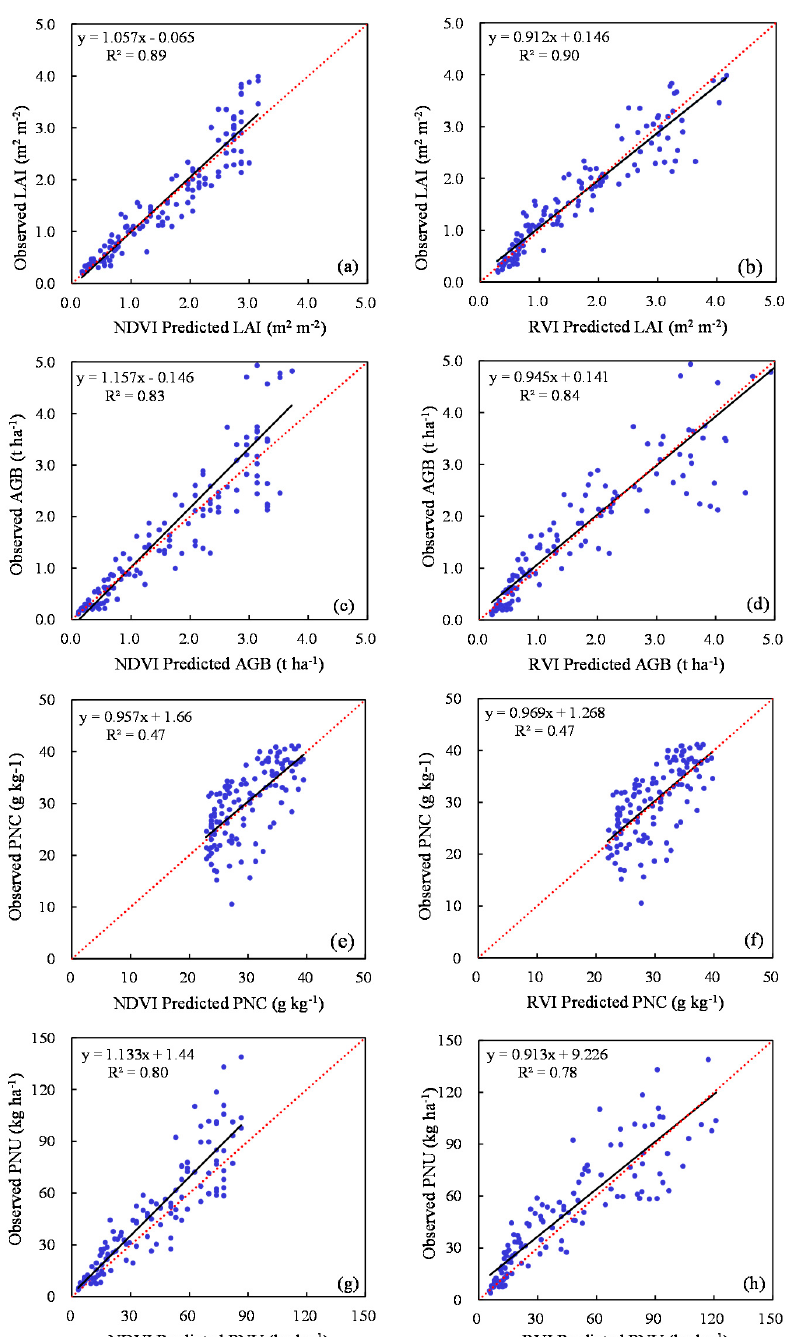
Figure 6. Relationships between the predicted and observed spring maize leaf area index (LAI) ( a , b ); aboveground biomass (AGB) ( c , d ); plant N concentration (PNC) ( e , f ); and plant N uptake (PNU) ( g , h ) for the validation dataset ( n = 132) using the established model across growth stages with GreenSeeker sensor-based indices (normalized difference vegetation index (NDVI) and ratio vegetation index (RVI)). Black and red lines indicate the regression and the 1:1 lines, respectively.